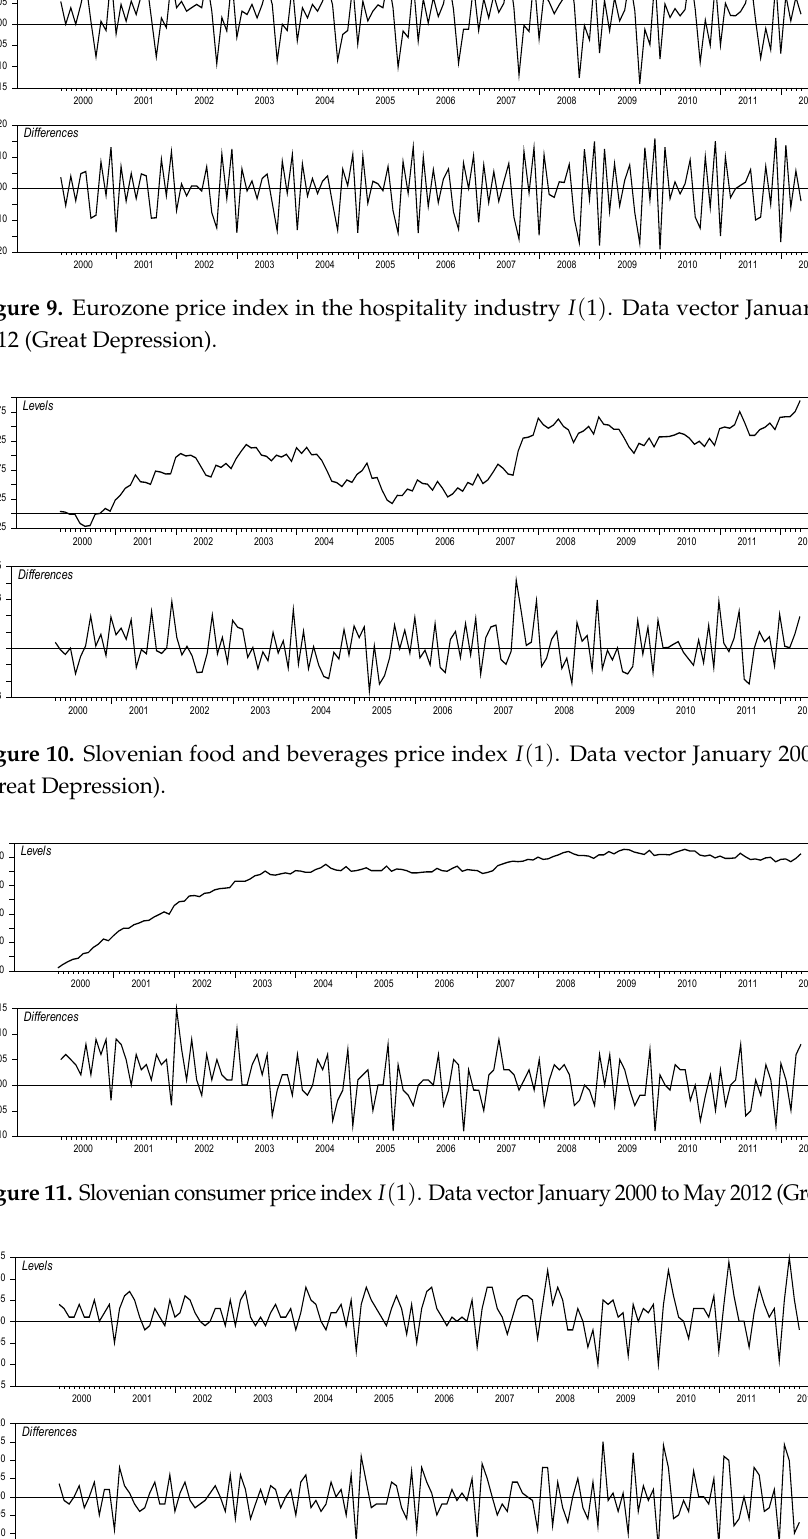
Figure 13. Slovenian price index in the hospitality industry 𝐼(1) . Data vector January 2000 to May 2012 (Great Depression). Utilising dummies to capture for remarkable mean-shifts, permanent blips, and tran- sitory shocks, the CVAR model from Equation (A7) (Appendix D) is reformulated as: ∆𝑋 (cid:3047) = Г (cid:2869) ∙ ∆𝑋 (cid:3047)(cid:2879)(cid:2869) + 𝛼 ∙ 𝛽 (cid:4593) ∙ 𝑋 (cid:3047)(cid:2879)(cid:2869) + +𝜙 (cid:3043) ∙ 𝐷 (cid:3043),(cid:3047) + 𝜙 (cid:3046) ∙ 𝐷 (cid:3046),(cid:3047) + 𝜇 (cid:2868) + 𝜀 (cid:3047) ,